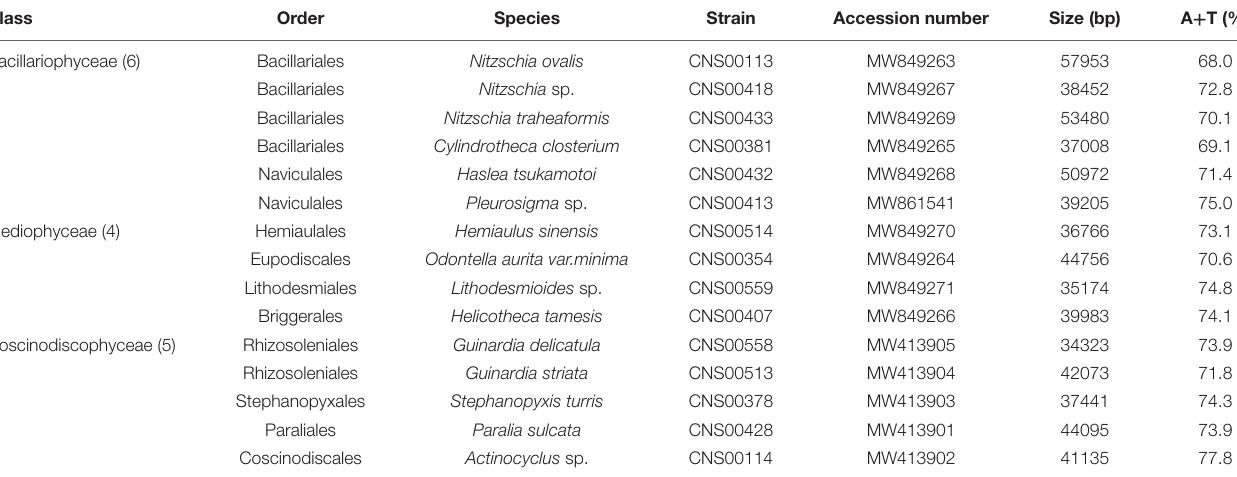
TABLE 2 | Genome features of 15 mtDNA from the Phylum